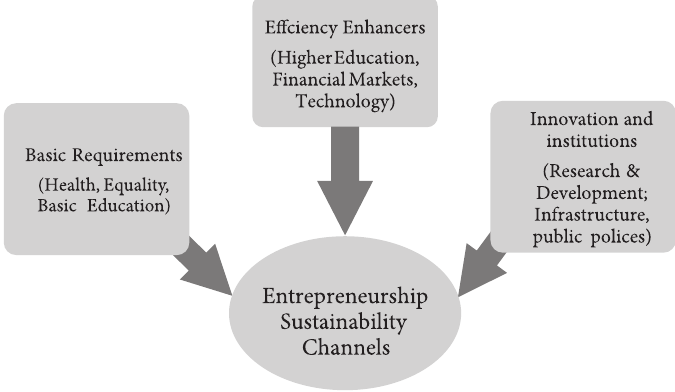
Figure 1. Entrepreneurship sustainability channels (source: adapted from Kelley et al.,